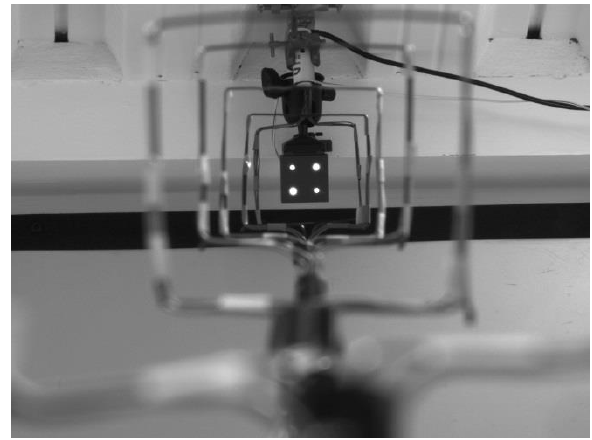
Figure 6. An overexposed image from the camera shows the quad target array surrounded by concentric thermocouple arrays.